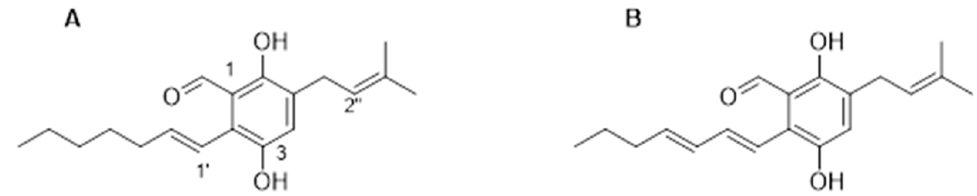
Figure 1. Chemical structures of ( A ) tetrahydroauroglaucin (TAG) and ( B ) dihydroauroglaucin